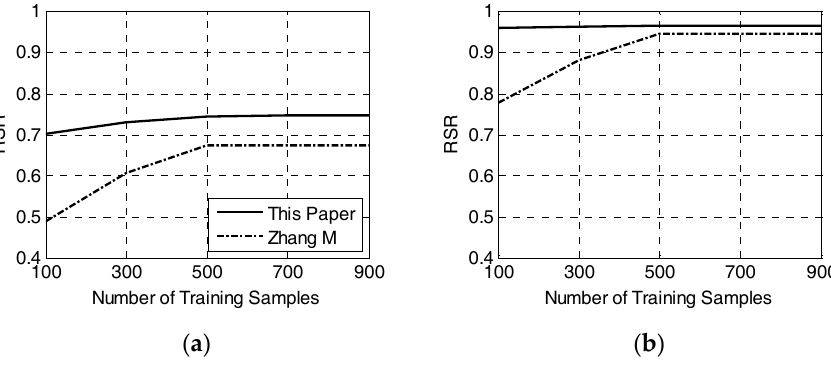
Figure 11. In this figure, ( a ) is the RSR at different training samples at SNR = − 8 dB. ( b ) is the result at SNR = − 2 dB.